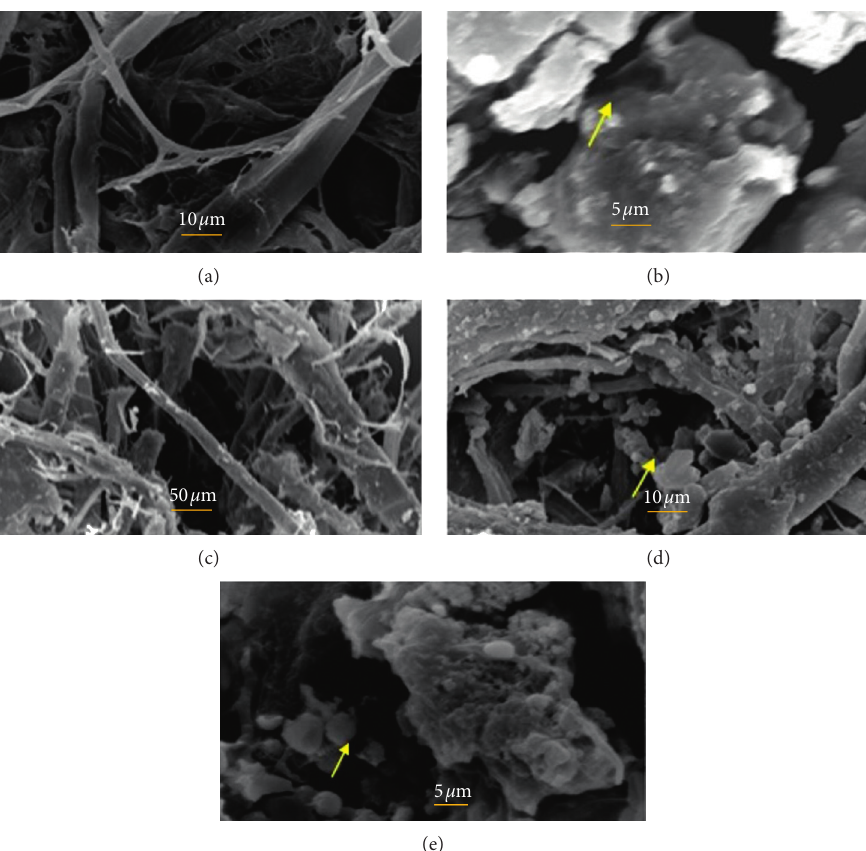
Figure 4: SEM images of surface appearance of a sample of the inner manuscript paper. (a) The surface appearance of the paper, whose fibers are near the pulp fibers of the cotton core. (b) The fillers in the paper approximating the shape of the calcite crystal (calcite in the papermaking process). (c) The shape of a cotton fiber and its distinctive cylindrical shape. (d, e) Erosion and weakness of paper fibers with disintegration in fibers.